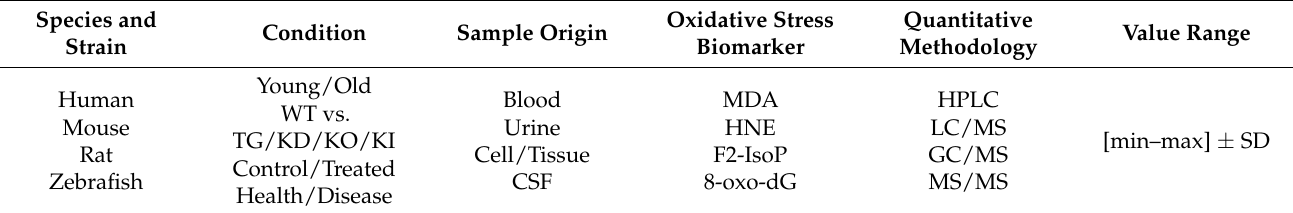
Table 3. Oxidative damage biomarkers: database